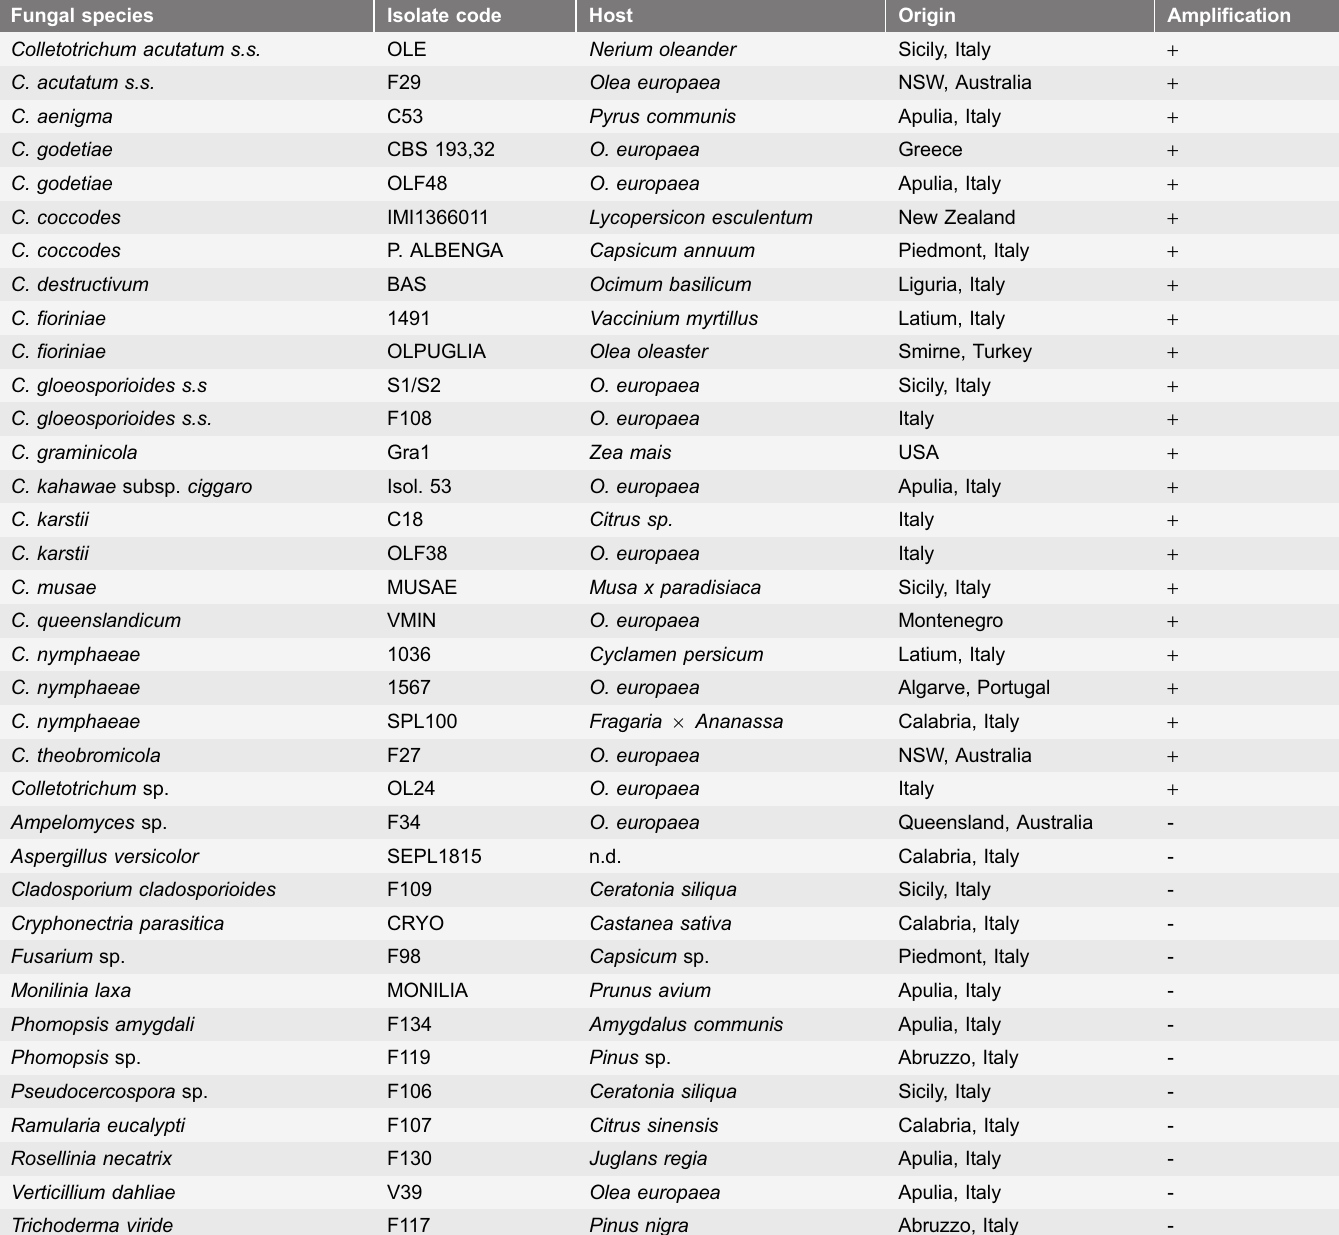
Table 1. List of species and isolates utilized to evaluate the specificity of Colletotrichum -genus-specific primers and corresponding positive ( + ) or negative (-) amplification results obtained in PCR reactions with pure culture DNA samples. Fungal